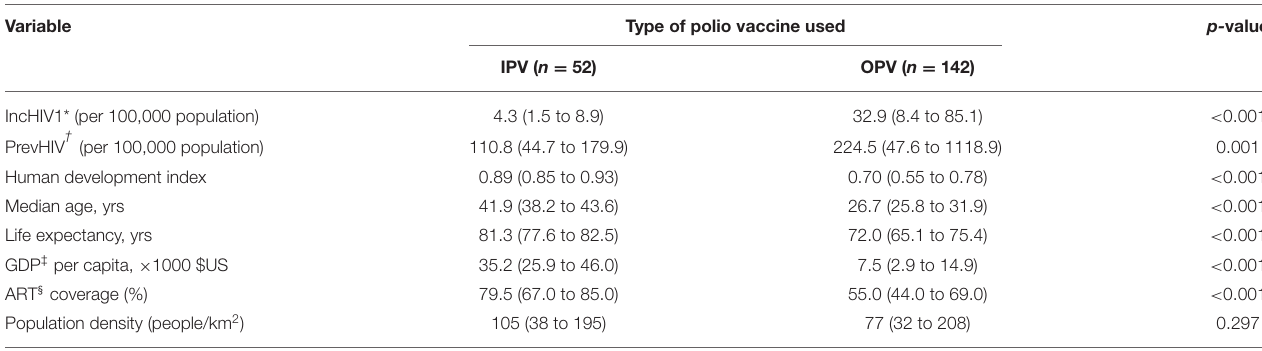
TABLE 1 | Median (IQR) of studied continuous variables in the original dataset stratified by the type of polio vaccine used.